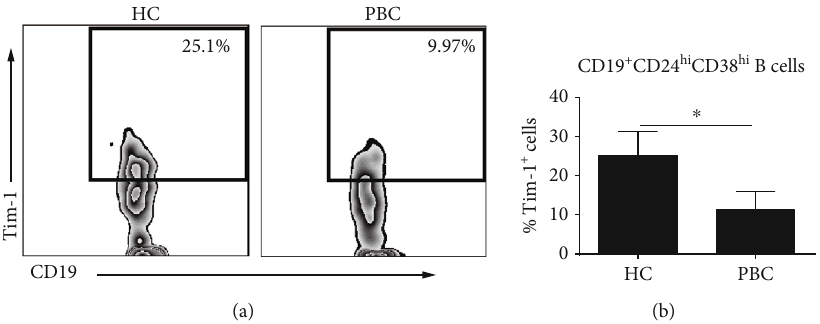
Figure 6: Tim-1 expression in CD19 + CD24 hi CD38 hi B cells was reduced in PBC patients. (a) Representative fl ow cytometric dot plots show the frequency of Tim-1 + cells in CD19 + CD24 hi CD38 hi B cells from PBC patients and HC subjects. (b) Statistical graph of the frequency of Tim-1 + cells in CD19 + CD24 hi CD38 hi B cells from PBC patients and HC subjects; ∗ P < 0 : 05